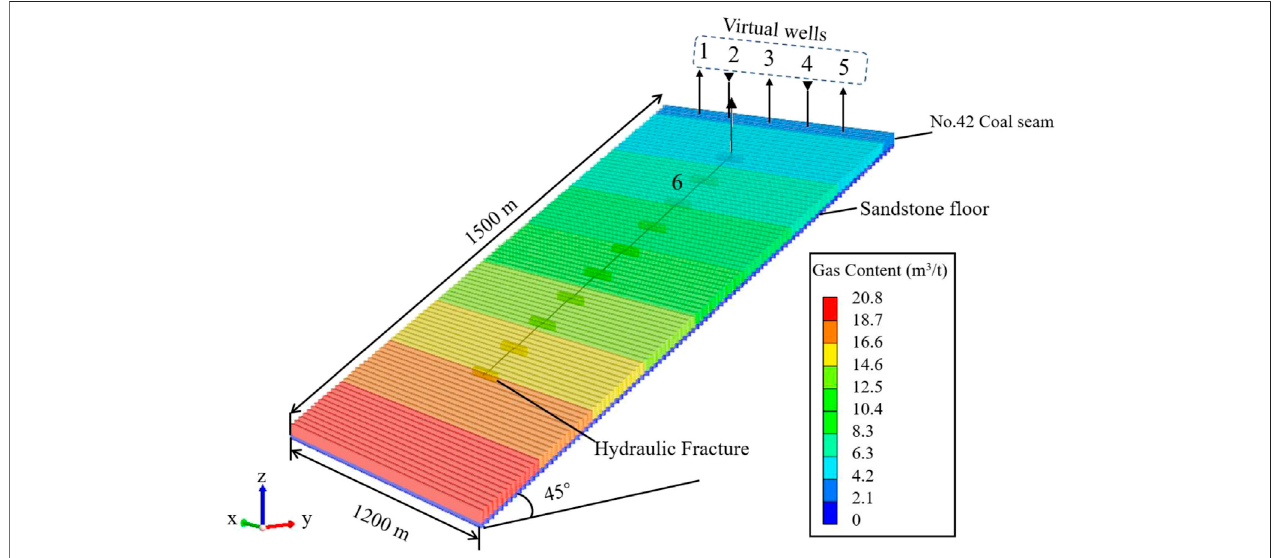
FIGURE 6 | Results of history matching for (A) gas production rate, (B) water production rate, and (C) adjusted relative permeability.